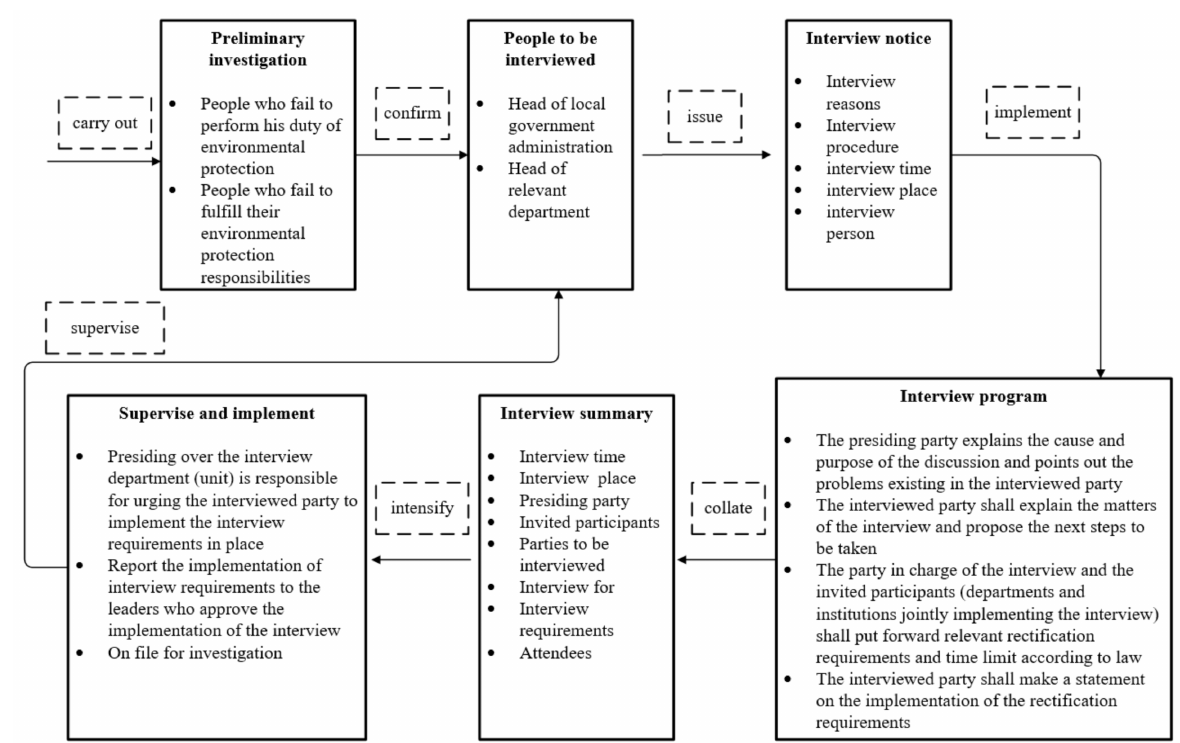
Figure 2. Structure and process of environmental interview